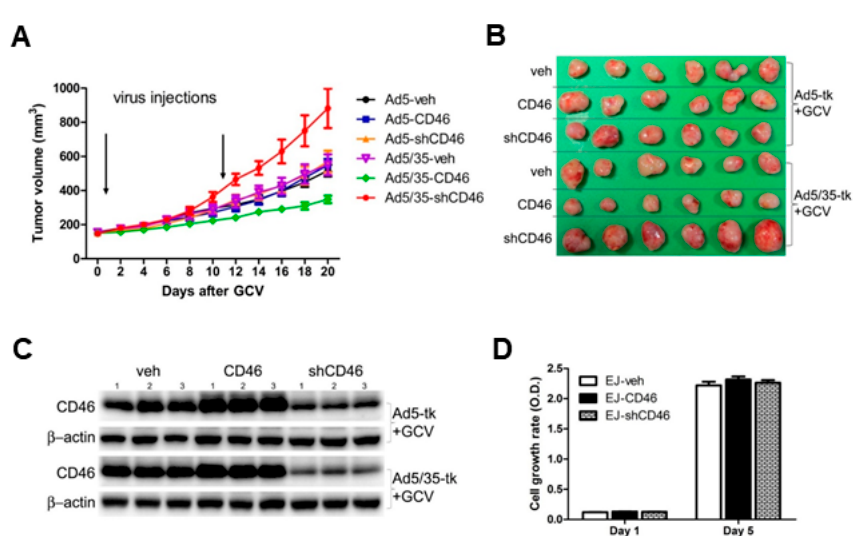
Figure 7. CD46 promotes Ad5/35 ‐ tk ‐ mediated cytotoxicity of xenograft bladder tumor growth in vivo. ( A ) CD46 overexpressing (CD46), CD46 suppressed (shCD46), or control EJ bladder cancer cells (veh) were injected subcutaneously into nude mice. Intra ‐ tumoral injections of Ad5/35 ‐ tk viruses (1.5 × 10 8 plaque ‐ forming units (PFU)) were performed twice at the indicated time points followed by intraperitoneal GCV injections (75 mg/kg) on days 2–12. Tumor growth was measured by a caliper at the indicated time points. ( B ) Representative photograph of tumor xenografts from mice treated with either Ad5 ‐ tk/GCV or Ad5/35 ‐ tk/GCV as described in ( A ). ( C ) Tumor tissue samples from the different tumor types and treatments were evaluated for CD46 expression by Western blot analysis. ( D ) Cell proliferation of each of different EJ cells was measured using the MTT assay. The error bars represent SEM. Statistics: A, p < 0.05 by two ‐ way ANOVA.